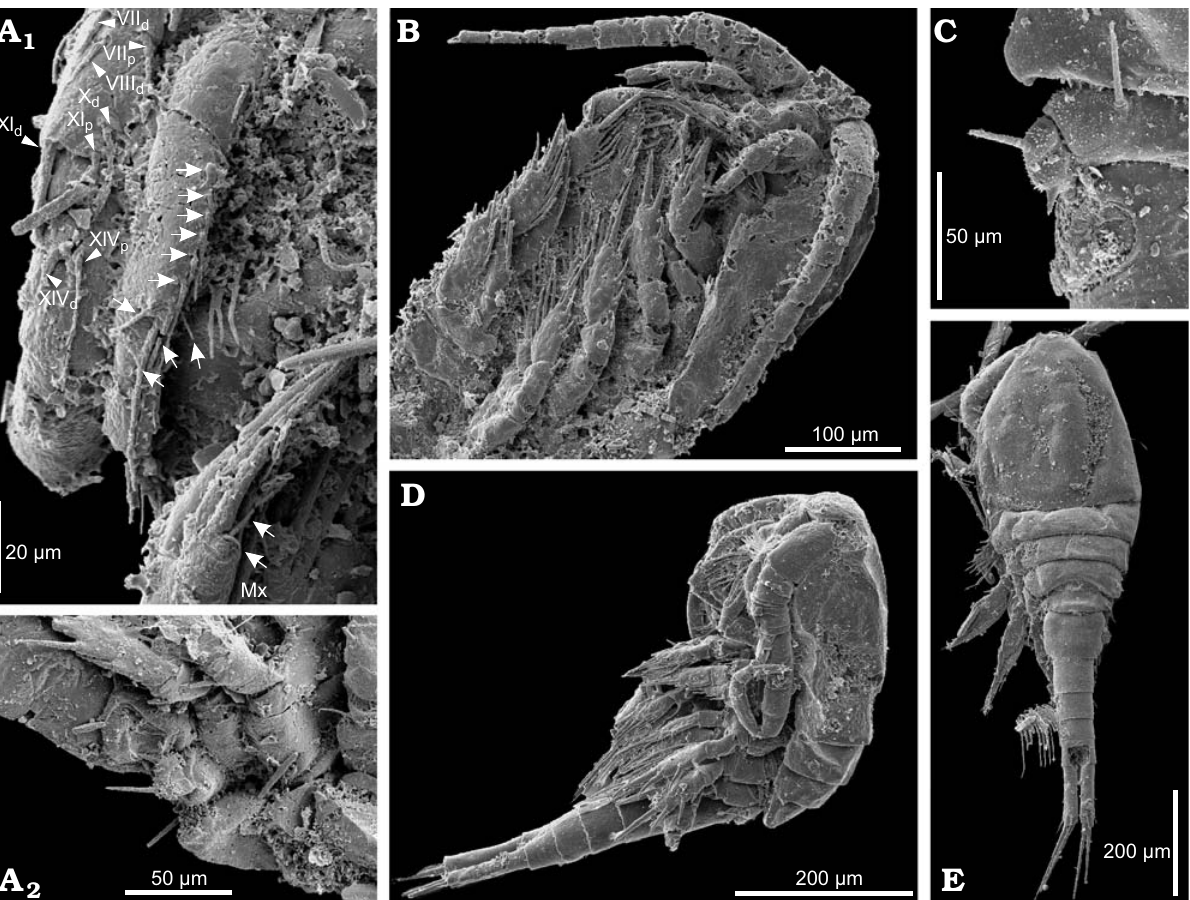
Fig. 3. Cyclopid copepod Apocyclops californicus sp. nov, from Mud Hills, Southern California; Burdigalian–Langhian, Miocene. A − C . Adult female. A . UMNH IP 4824 holotype, median section of the antennule showing some setae coded on segments 2 − 5 (VII − XIV) and antennal endopodite in anterior view (A 1 ), spinulose surface ornamentation of pediger 5 and free segment of leg 5 in ventral view (A 2 ); p or d means anteroproximal- or anterodistal seta, arrows point to ten setae on the second (penultimate) endopodal segment of the antenna, and two short setae on the distal endopodal segment of the maxilla (Mx). B . UMNH IP 4845, prosome with four pairs of the swimming legs in lateroventral view. C . UMNH IP 4852, spinulose surface ornamentation of pediger 5 and free segment of leg 5 in dorsal view. D , E . Adult male habitus. D . UMNH IP 4858, in lateroventral view. E . UMNH IP 4856, in dorsal